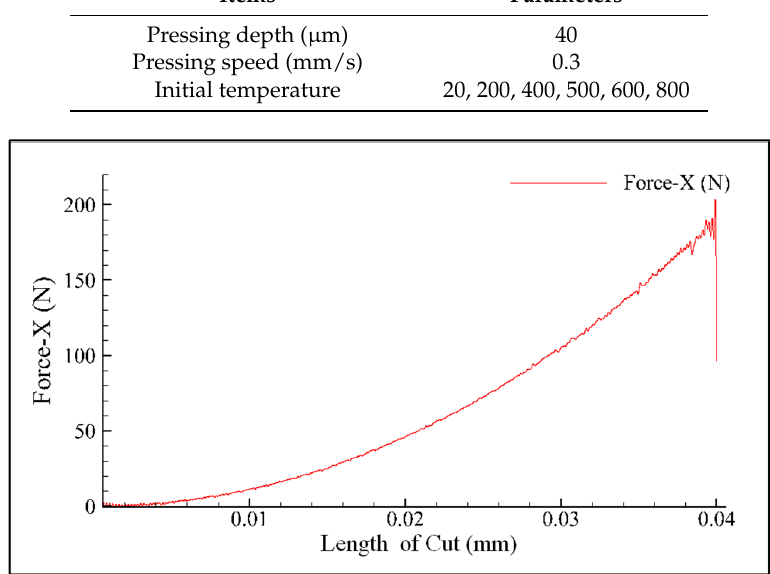
Figure 11. The result of the AdvantEdge TM outputted (initial temperature = 20 °C).